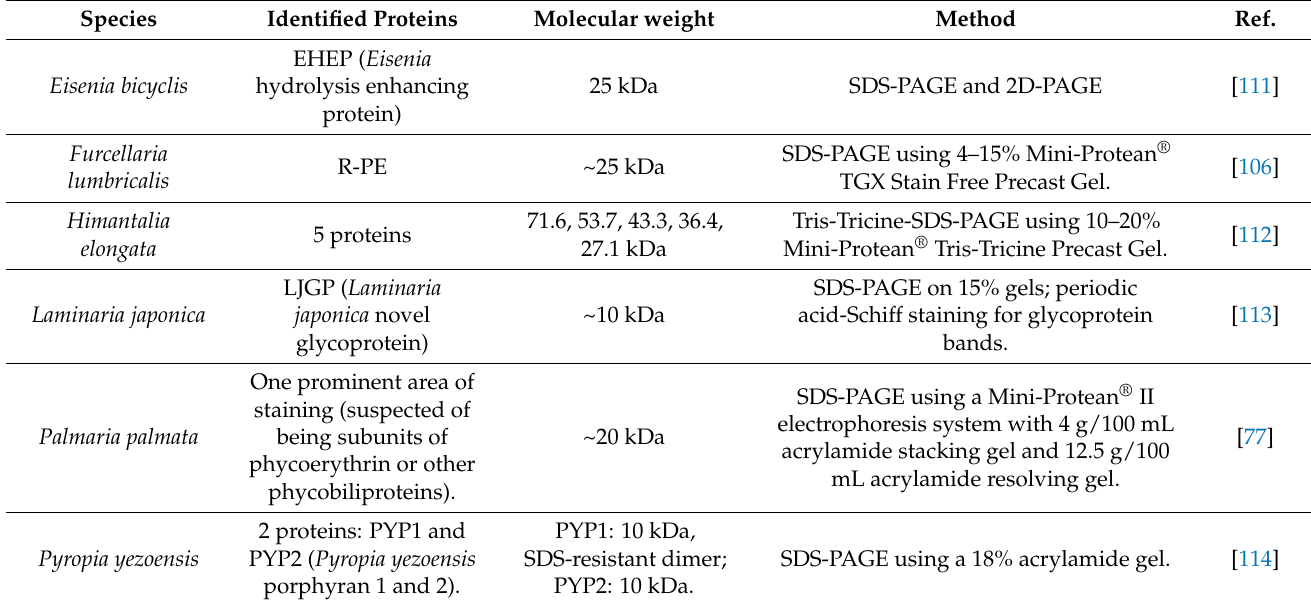
Table 5. Protein isolation and characterization using SDS-PAGE methods in different seaweed species. Species